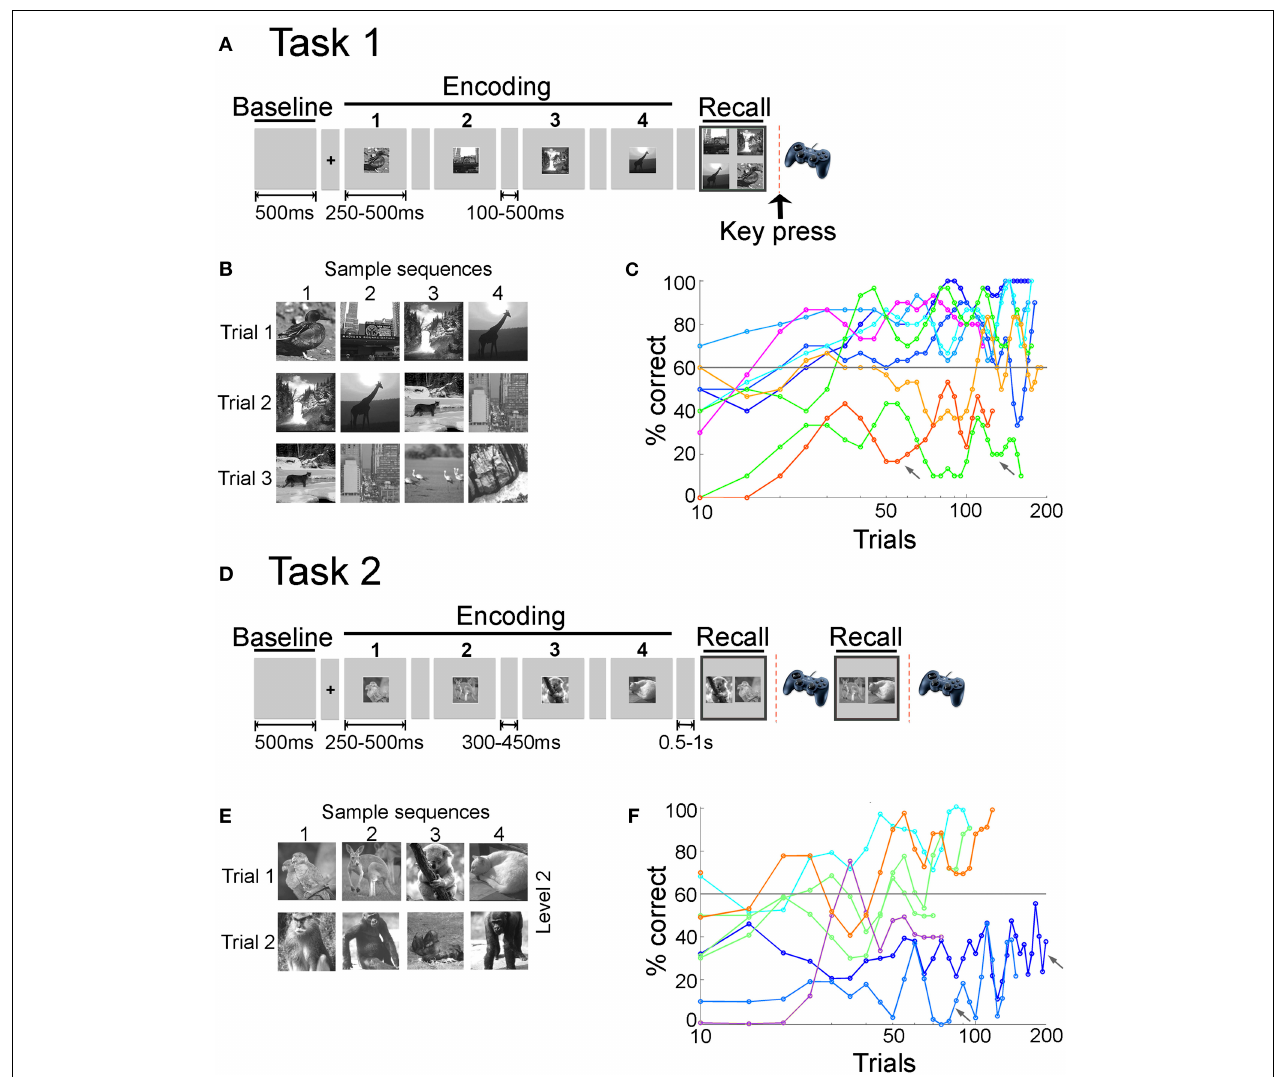
FIGURE 1 | Sequence encoding tasks and learning behavior. (A) In Task 1, each trial started with a fixation screen (100 or 500ms) followed by a sequence of four images, each one presented for either 250 or 500ms, referred to as the encoding phase. After a short delay (100 or 500ms), the four images were presented together on the screen in the recall phase. The subjects had to report the order of the four images using a gamepad (key press) (Materials and Methods). (B) Sample images presented during Task 1. Each sequence consisted of four images from a pool of eight images per session. Images were always presented in the same order and three or five overlapping sequences were shown per session. (C) Behavioral performance for Task 1. Performance in a given trial was considered correct if the subject reported the right order for all four images in the sequence (out of the 24 possible combinations in which four buttons can be pressed, only one of them was correct). Here we show the average performance (percentage of correct trials, y-axis) for each subject (eight subjects) and session in bins of 10 trials (x-axis, note the logarithmic scale). Colors indicate different subjects; for one subject there are two separate lines, indicating different sessions (green line). The gray line indicates the learning criterion of 60% correct (Materials and Methods). Arrows indicate sessions in which the subjects’ performance did not satisfy the learning criterion. On average, subjects needed 28 ± 11